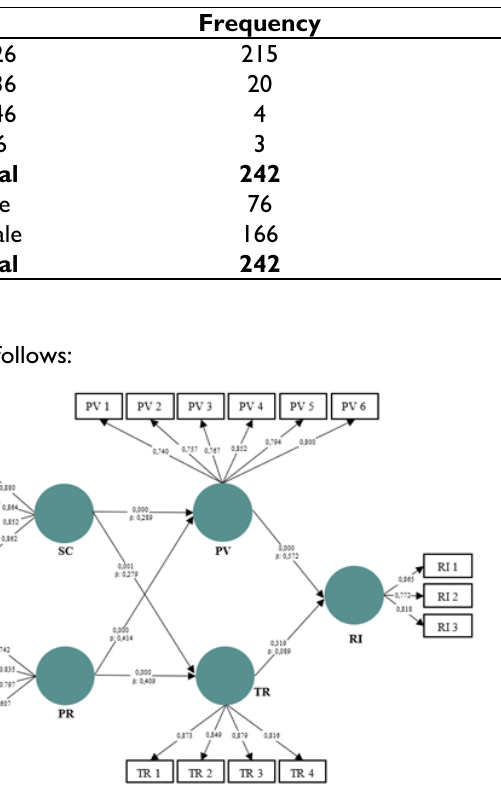
Table 2. Characteristics of Respondents